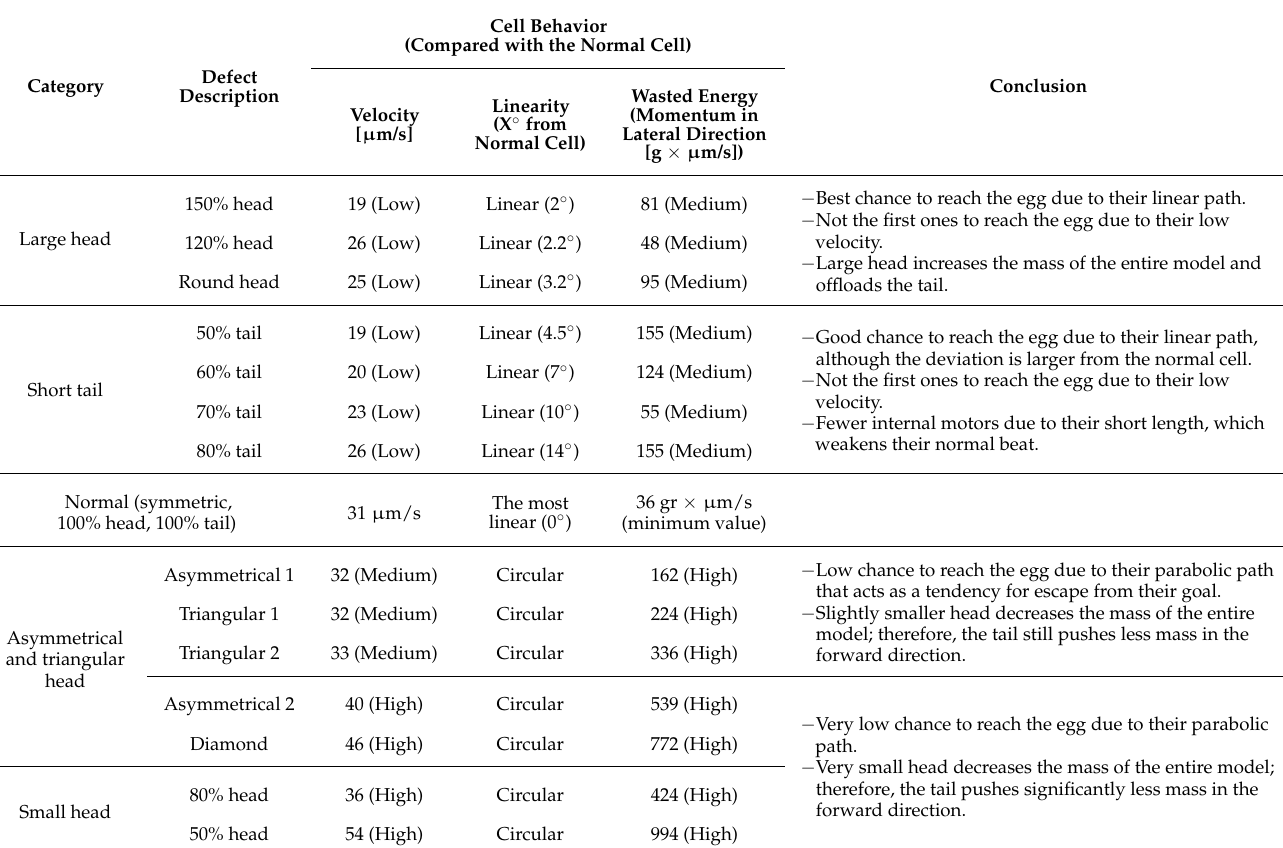
Figure 8. Normal and abnormal model swimming patterns over 15 min, starting on the right. Two-dimensional trajectories in the ‘ x − y ’ plane ( a ) and in the ‘ x − z ’ plane ( b ). Table 1. Scoring of sperm pathology categories according to their chances of reaching the